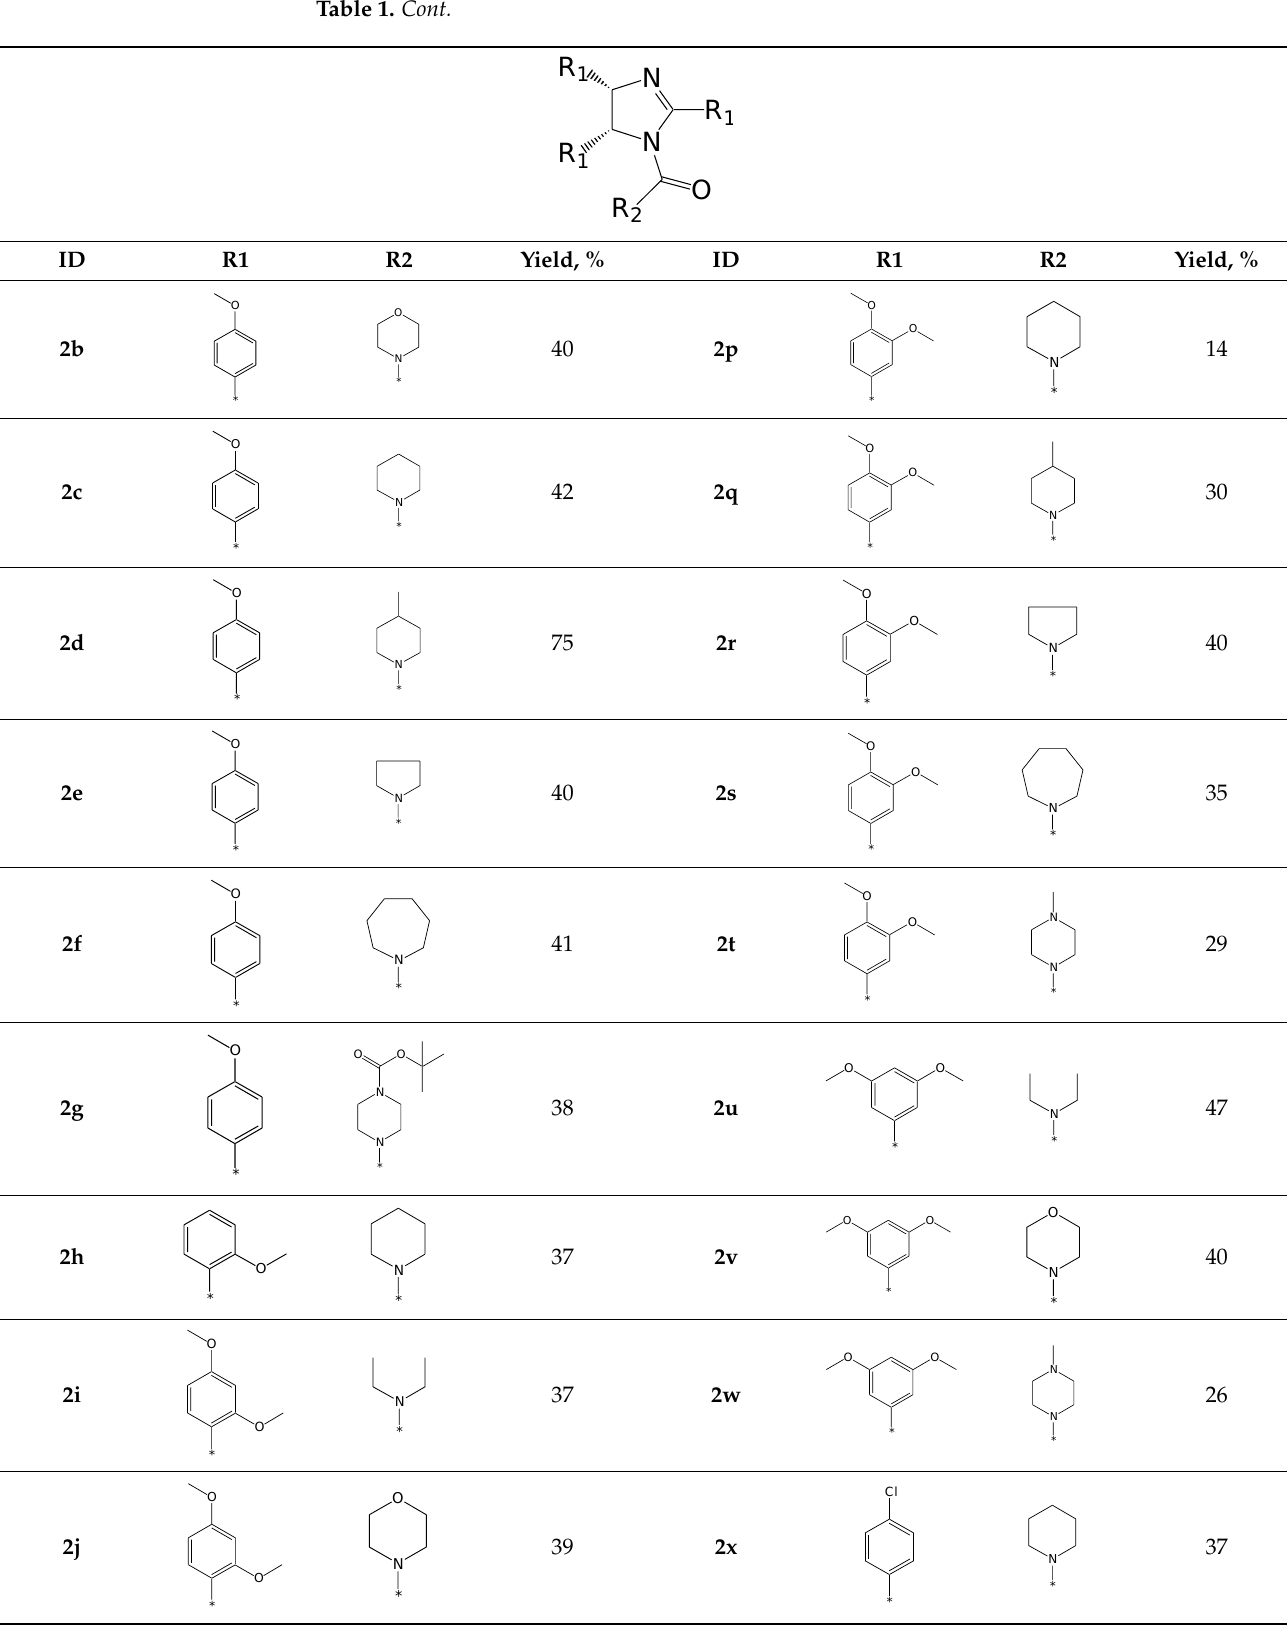
Figure 1. ( A ). The structures of novel p53-MDM2 interaction inhibitors 2l and 2k and known refer- ence molecules Nutlin-3a (1) and RG7112 (3). ( B ). The principal synthesis approaches for nutlin de- rivatives. ( C ). The described approach for the synthesis of RG7112 [10]. ( D ). The developed ap- proach. Table 1. Cont. Table 1. Synthesized 2,4,5-triaryl cis-imidazoline